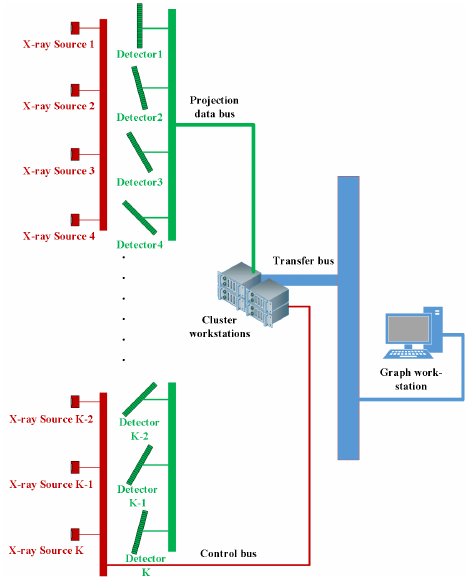
Figure 5. Data transmission network.